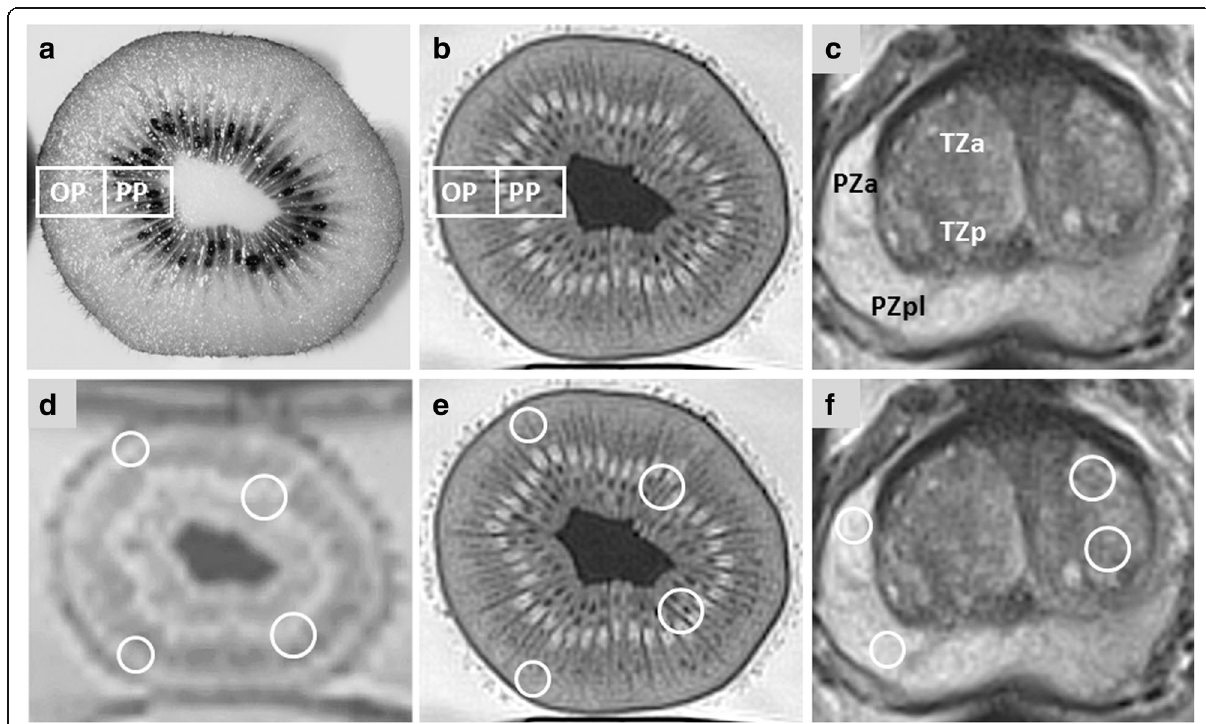
Fig. 2 Axial images of a green Hayward kiwifruit, Actinidia deliciosa ( a digital photograph of fresh cut section; b corresponding T2-weighted image [T2WI]; OP, outer pericarp; PP, peripheral placenta) and a human prostate (c T2WI: PZa, anterior region of peripheral zone; PZpl, posterior region of peripheral zone; TZa, anterior region of transitional zone; TZp, posterior region of transitional zone). Respective placement of elliptical regions of interest (ROIs) comprising at least ten adjacent voxels is demonstrated in axial images of a kiwifruit ( d diffusion-weighted image, b value 800 s/mm 2 ; e T2WI) and human prostate ( f